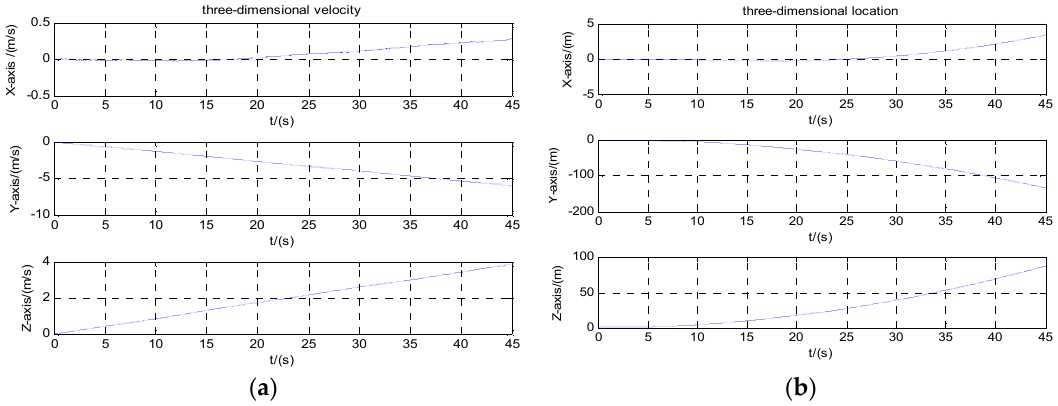
Figure 6. Velocity and position before compensation: ( a ) velocity; ( b ) position.